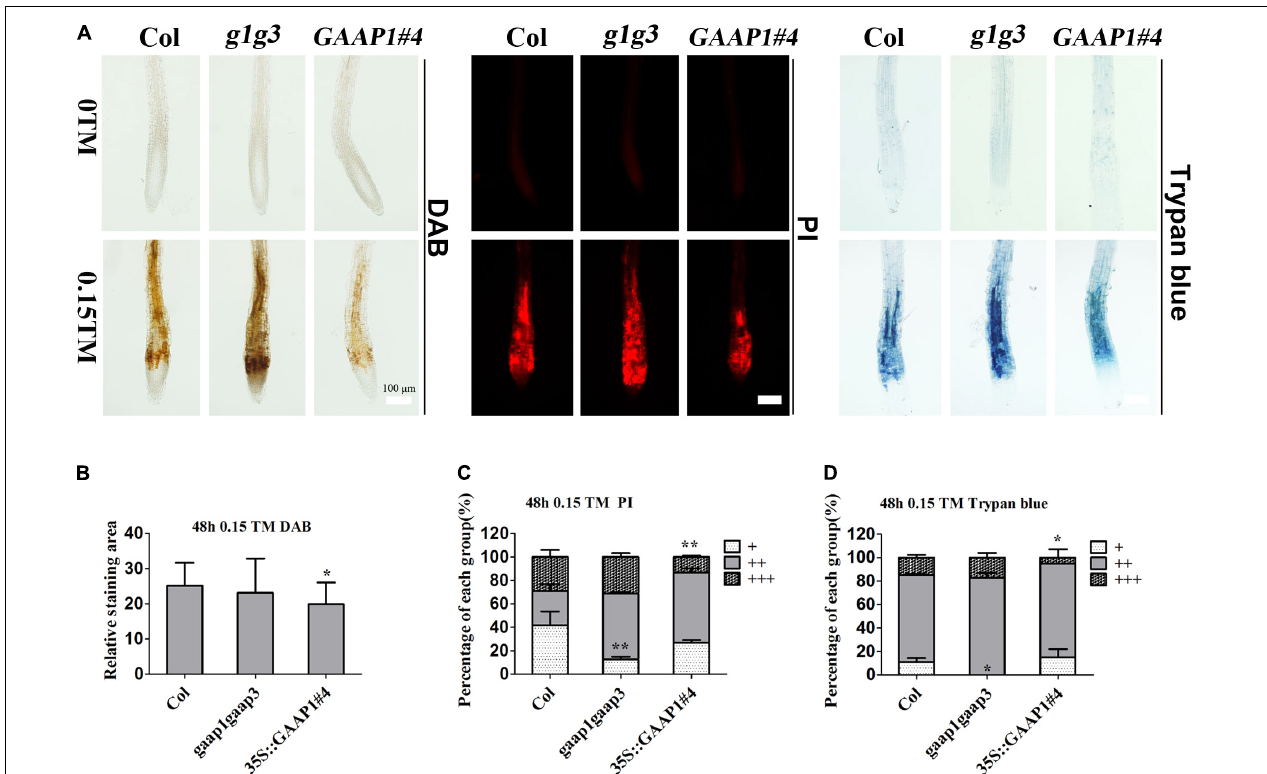
FIGURE 6 | GAAP1/GAAP3 inhibited the cell death induced by ER stress. (A) The 3-day-old seedlings that were vertically cultured were transferred to a new culture plate containing different concentrations of TM. Root cells of Col, gaap1gaap3 (g1g3), and 35S::GAAP1#4 treated without or with 0.15 µ g mL − 1 TM for 48 h were stained by DAB, PI, and trypan-blue. Bar = 100 µ m. (B–D) The H 2 O 2 level (B) and cell death severity (C,D) were analyzed by quantifying the staining degree. DAB staining area of the signal intensity more than a certain threshold was determined by ImageJ software. PI and trypan blue staining intensity were classified in three levels, namely, faint, medium, and strong, and depicted as “+”, “++”, and “+++”, respectively, according to Supplementary Figure S4. The percentage of each group was calculated. Error bars represent standard deviation. Significant differences compared with Col plants were indicated by asterisks (student test, ∗ p < 0.05, n (cid:61)